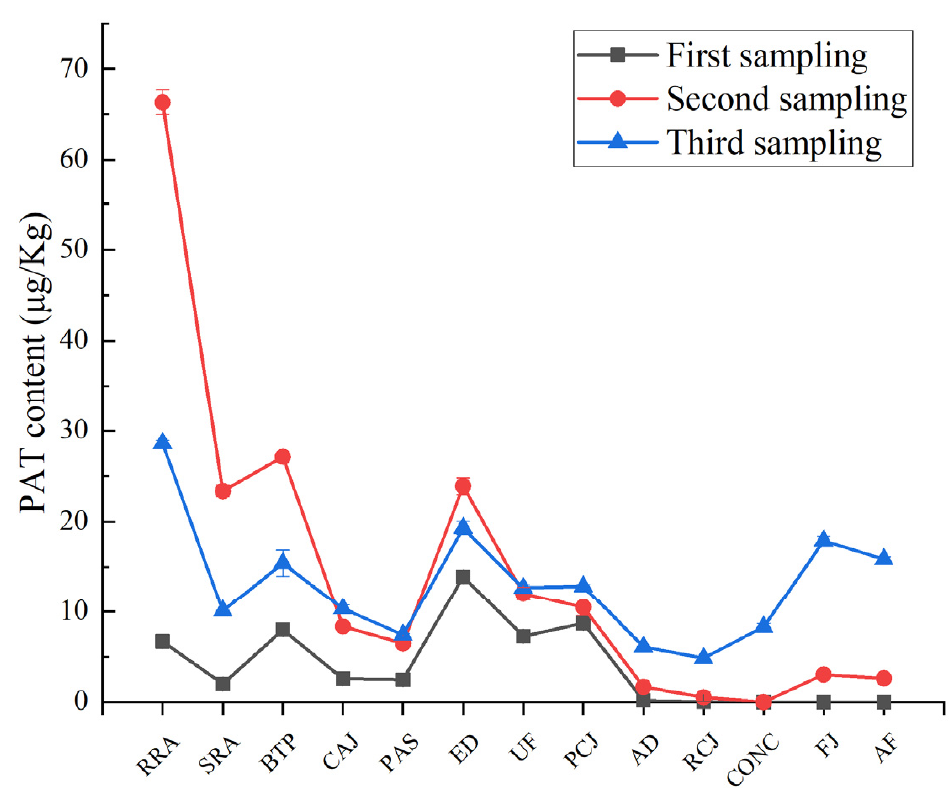
Figure 2. PAT content changes in three samplings. Abbreviations: RRA — receipt of raw apples. SRA — sorting of raw apples. BTP — belt-type pressing. CAJ — cloudy apple juice. PAS — pasteuriza- tion. ED — enzymatic digestion. UF — ultrafiltration. PCJ — pre-clear juice. AD — adsorption. RCJ —